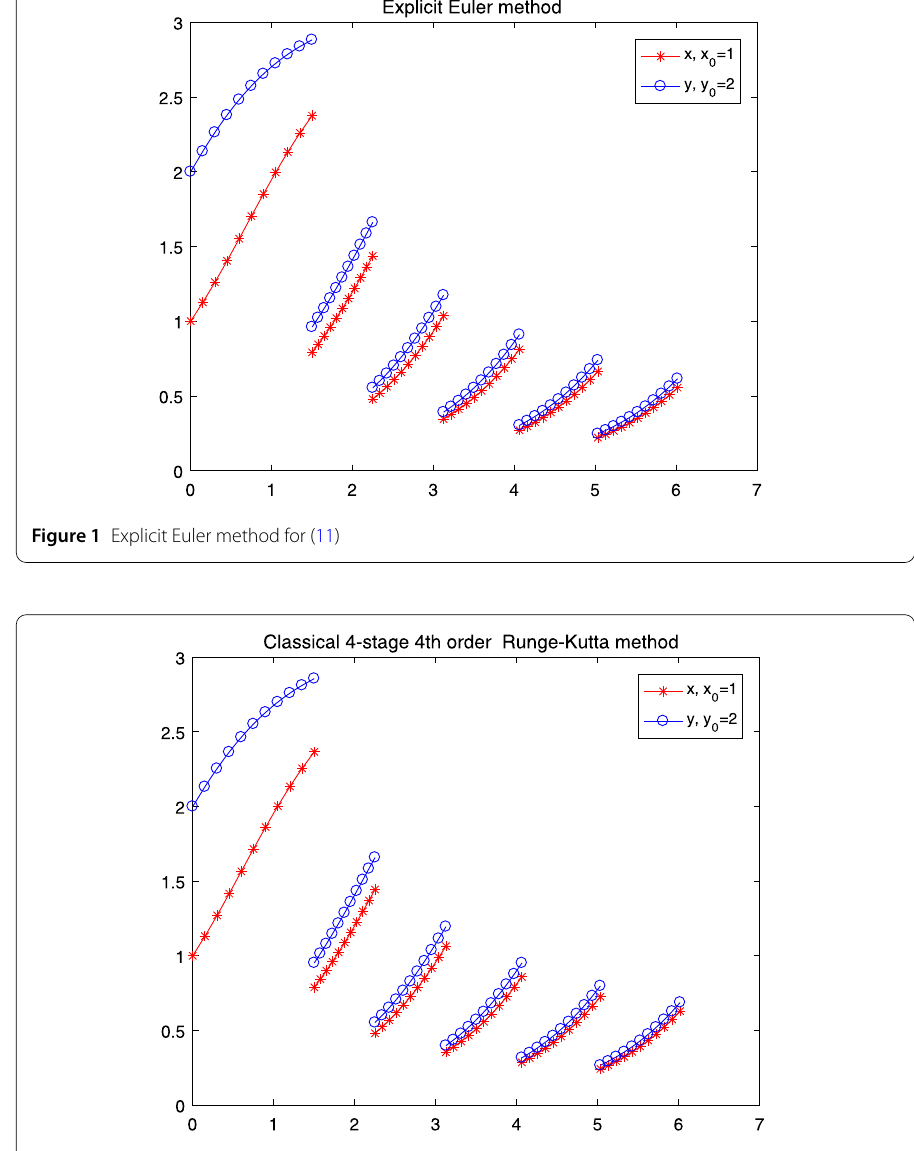
Figure 2 The classical 4-stage fourth order Runge–Kutta method for